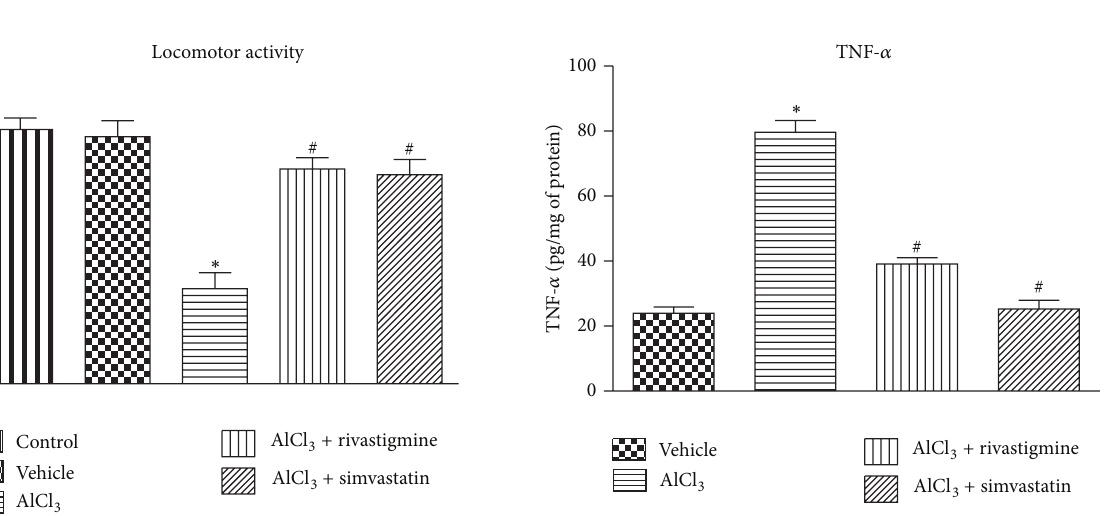
-induced biochemical changes on hippocampus. 3